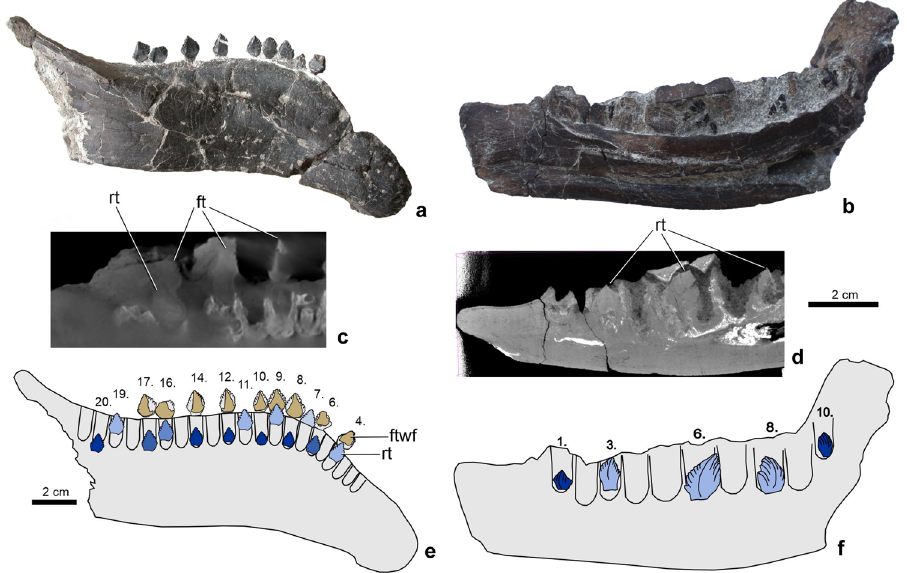
Figure 2. Dentaries of Hungarosaurus tormai and Mochlodon vorosi that were micro- and nanoCT scanned to reveal replacement teeth. ( a ) Lateral view of the right dentary of Hungarosaurus tormai (MTM 2007.25.2) with functional and replacement teeth. ( b ) Medial view of the right dentary of Mochlodon vorosi (MTM V 2010.104.1) with replacement teeth. ( c ) microCT scan of the right dentary of Hungarosaurus tormai showing replacement teeth. ( d ) nanoCT scan of the right dentary of Mochlodon vorosi showing replacement teeth. ( e , f ) Schematic drawings of the dentaries of Hungarosaurus tormai and Mochlodon vorosi showing the functional and replacement teeth. ft, functional tooth; ftwf, wear facet on the functional tooth; rt, replacement